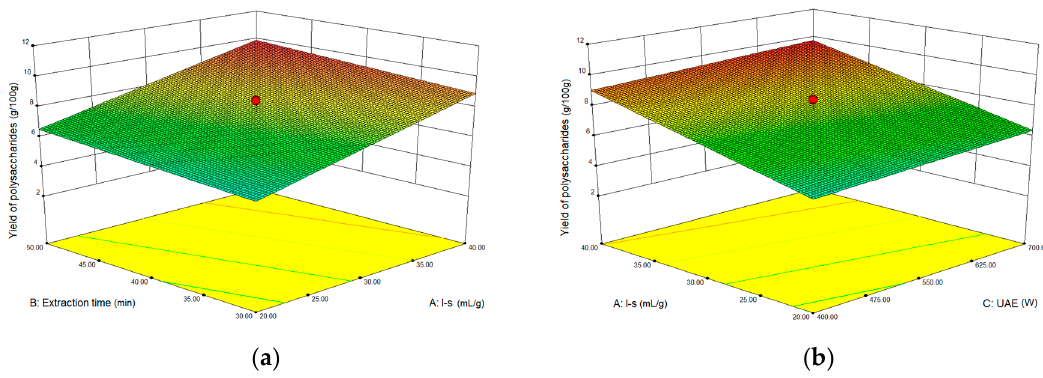
Figure 4. The response surface for the effect of independent variables on ultrasound-assisted extraction efficiency of polysaccharides. ( a ) Solid–liquid ratio and extraction time, ( b ) solid–liquid ratio and ultrasound power.